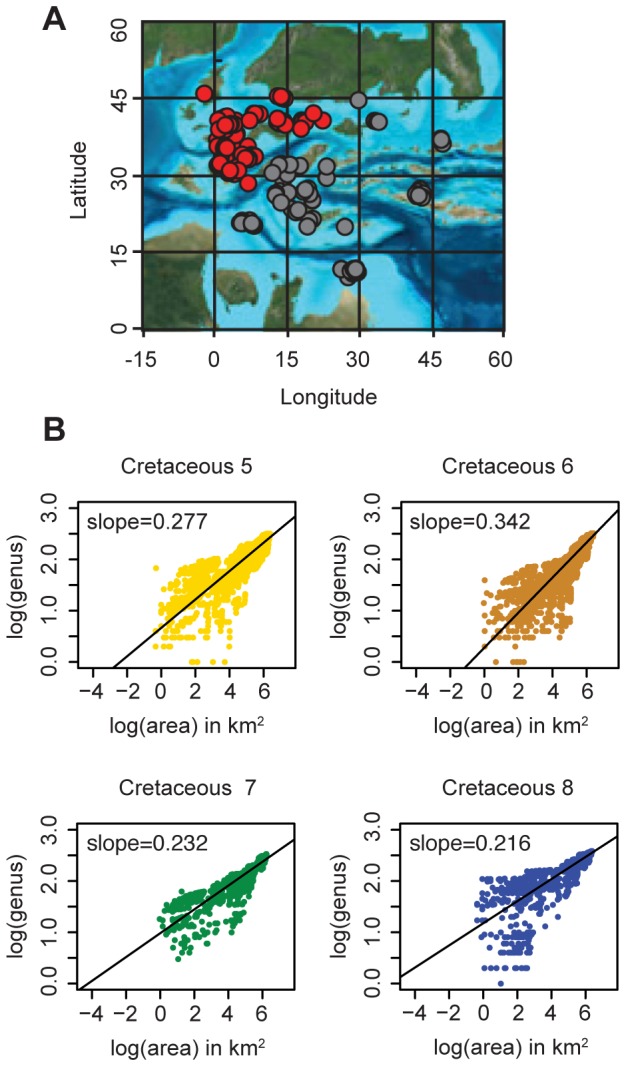
European Epicontinental Sea PaleoDB Collections.(A) Paleogeographic map of Europe (105Ma). Gray dots represent all PaleoDB collections from the European Epicontinental Sea used in full analyses; red dots represent collections used as a subset for the European Epicontinental Sea analysis. Map: Ron Blakey, NAU Geology [21]. (B) Genus-Area plots with least-squares linear regression of subseted European Data.